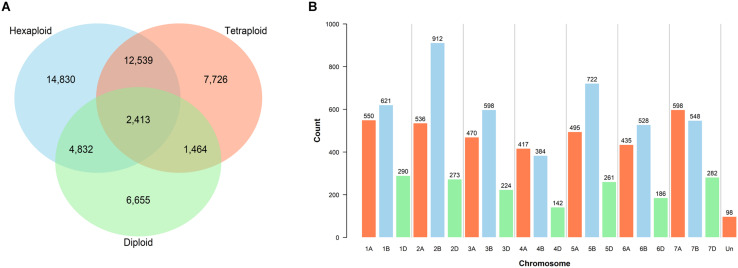
Filtered single nucleotide polymorphism (SNP) markers. (A) Shared SNPs between the hexaploid, tetraploid and diploid datasets. (B) Distribution of 9,570 filtered and validated SNPs across the chromosomes of the CS reference genome v1.0 (IWGSC, 2018).